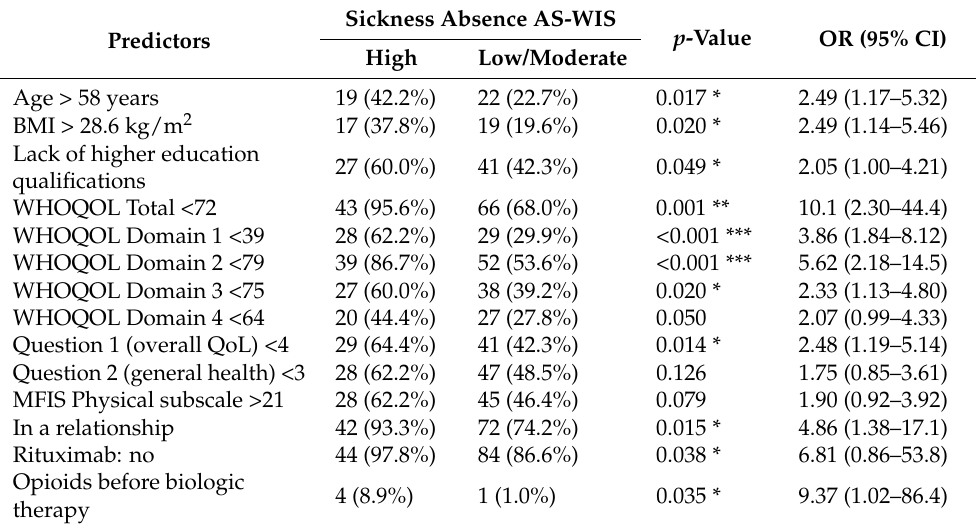
Table 8. The number (percentage) of patients in groups differing in the risk of incapacity for work and selected predictors, as well as estimates of the odds ratios and their 95% confidenc-intervals— one-dimensional analysis.